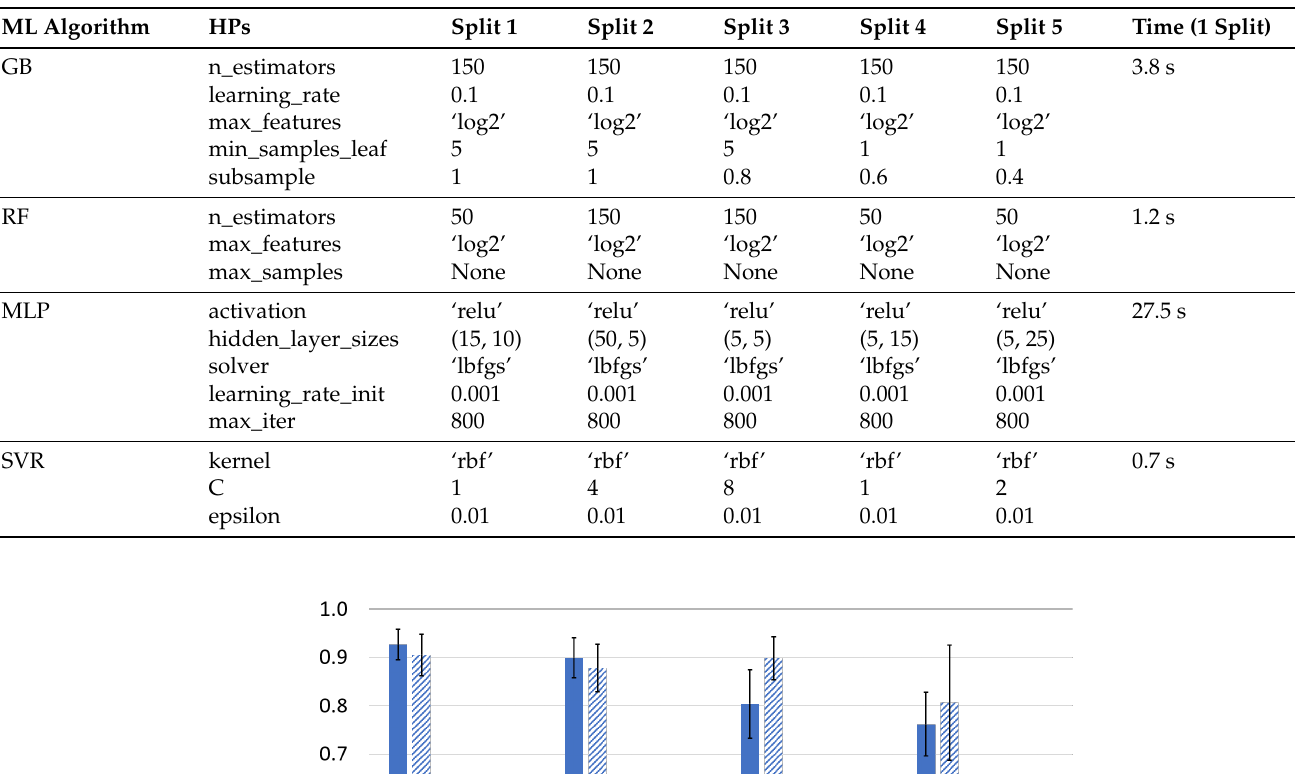
Table 4. HPs optimized for each train/test split, for GB, RF, MLP and SVR.